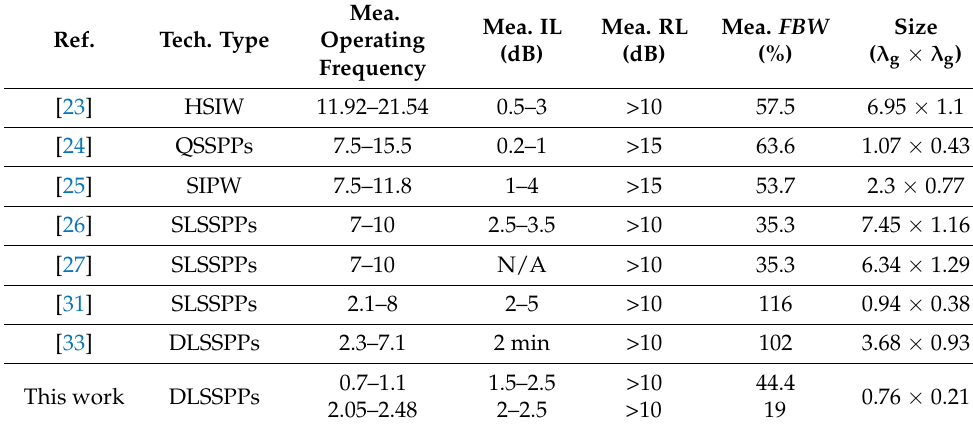
Table 1. Comparison of the filter with other spoof surface polariton-based filter designs. ( λ g is the guided wavelength at the center operating frequency and Mea. is the abbreviation of measurement.)